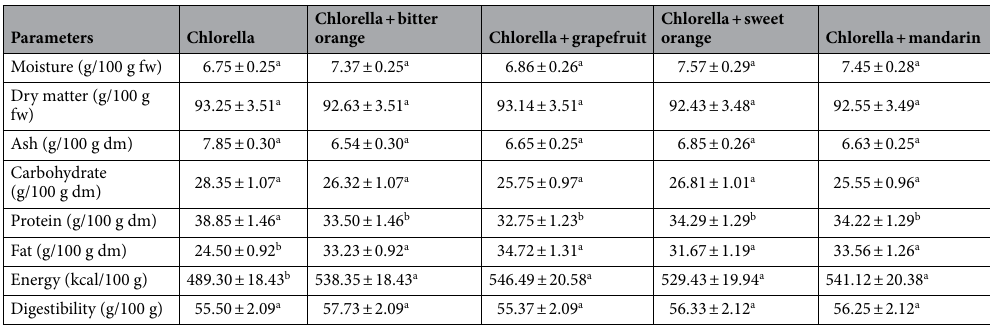
Table 3. Biochemical composition of Chlorella vulgaris supplemented with of bitter orange, sweet orange, grapefruit, and mandarin peel fatty acid. The values are expressed as means ± SD for three replicates experiments. Mean values with similar letters within a row are statistically similar, while mean values with different letters within a row are significantly different by the Tukey test ( P < 0.05). fw fresh weight, Dm dry